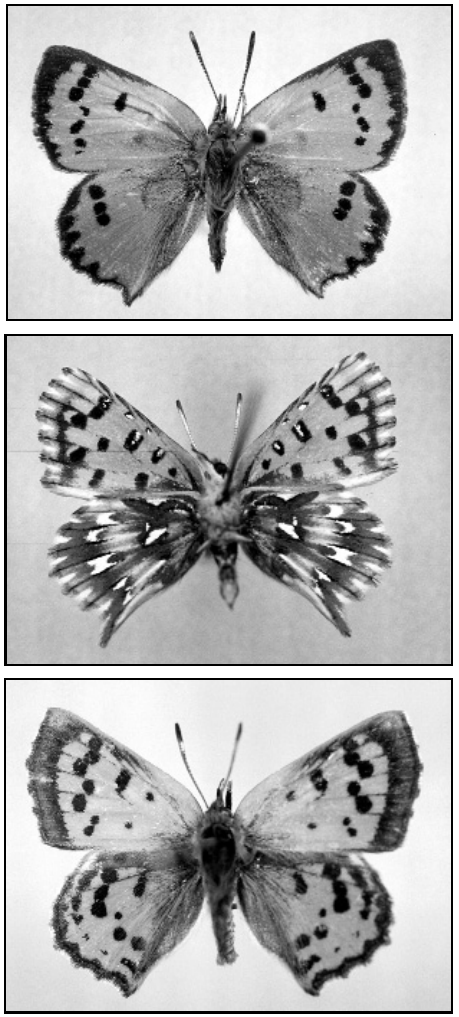
Fig. 1. Examples of Chrysoritis species. Top: C. aethon ; Middle: C. pelion; Bottom: C.